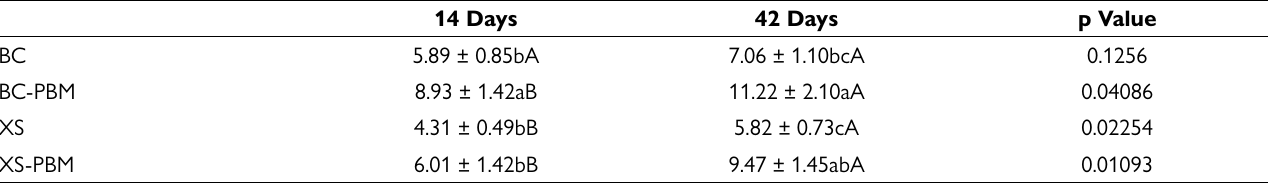
Table 2. Percentage of new bone formation in each group in the two experimental periods (14 and 42